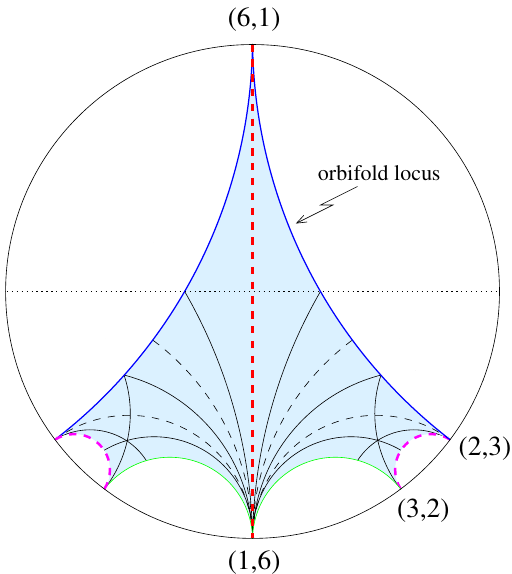
Figure 3 . The moduli space of the coupling (cid:28) = C 0 + i=g s (here mapped from the upper half-plane to the Poincar(cid:19)e disk) has a cusp for every decomposition of N into two factors ( n 1 ; n 5 ) such that N = n 1 n 5 . This slice of the moduli space is the fundamental domain of the congruence subgroup (cid:0) 0 ( N ) of SL(2 ; Z ); n 5 copies of the SL(2 ; Z ) fundamental domain meet at the cusp